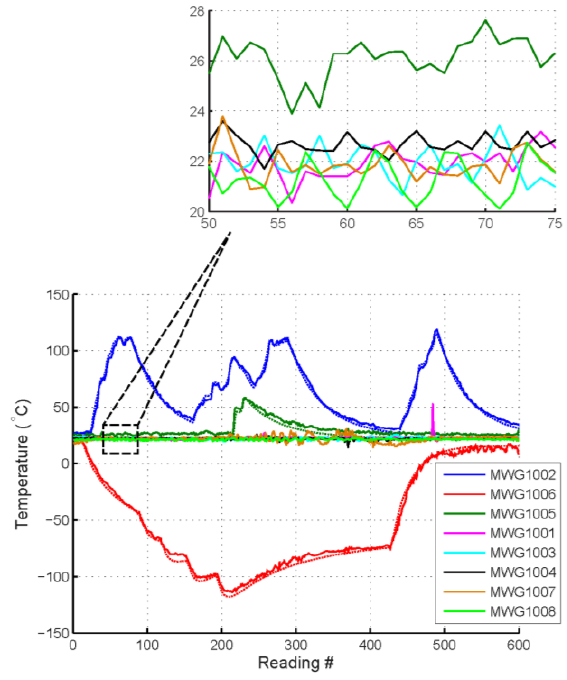
Figure 17. Wireless OFC 8-sensor synchronous temperature sensor system data extraction in an open-atrium from approximately 4 meters in range. Synchronous integration of four sweeps per sample per data point. Two sensors are repeatedly heated or cooled; then allowed to return toward ambient temperature. The heated and cooled sensors have an attached thermocouple to illustrate the